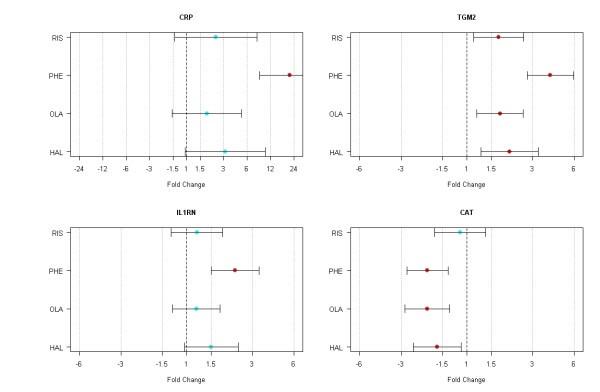
Effects of individual AP drugs on gene expression are shown with fold change and 95% confidence intervals. These genes show differential expression profiles in the liver by the individual AP drugs. Values are expressed as fold changes compared to the unaffected controls. Red: significant from the controls (FDR p < 0.05). RIS, risperidone; PHE, phenothiazines; OLA, olanzapine; HAL, haloperidol.